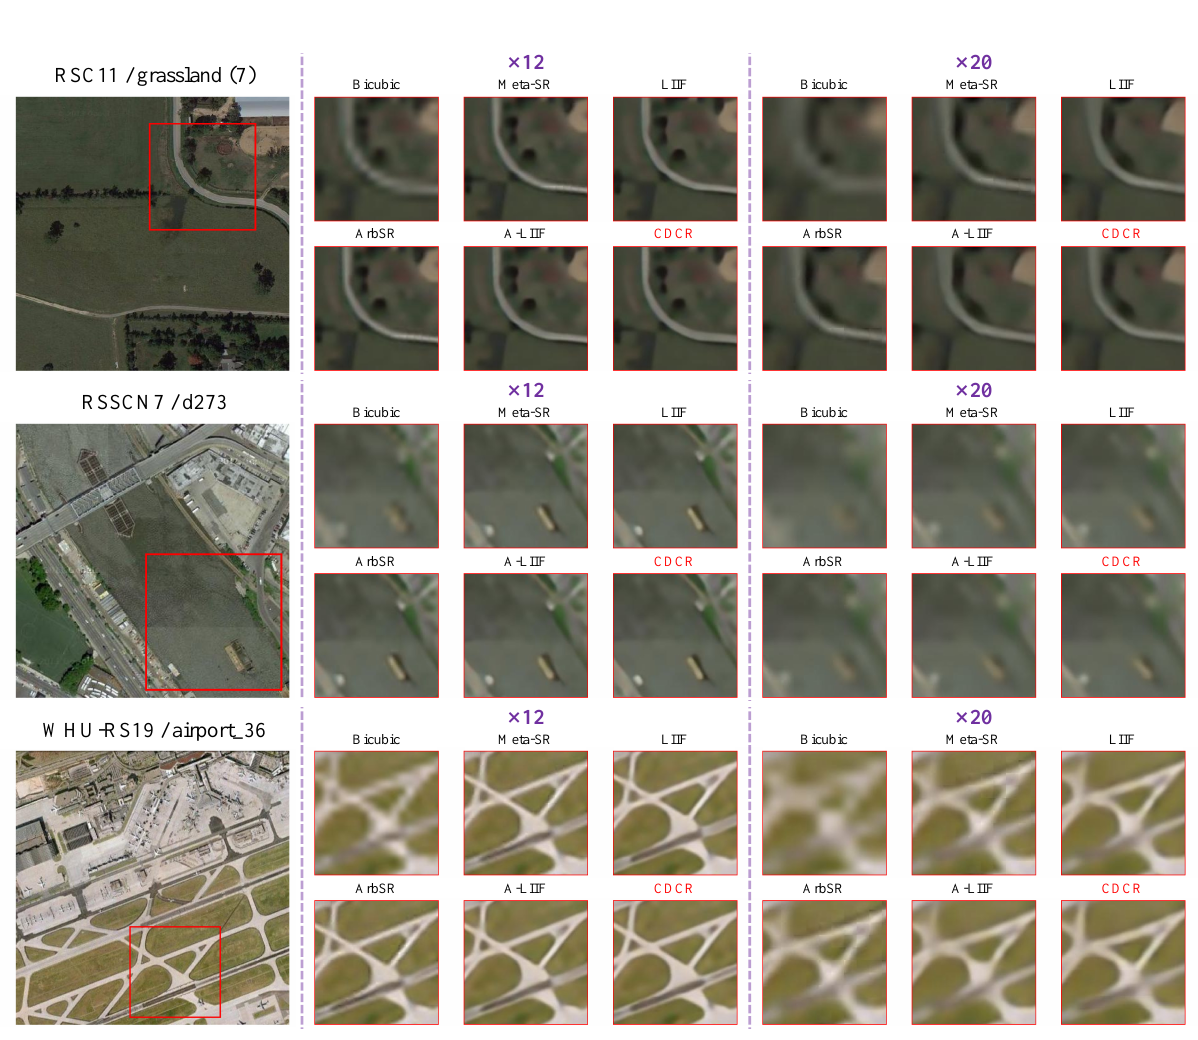
Figure 7. Visual comparison of the different methods at scale factors of 12 and